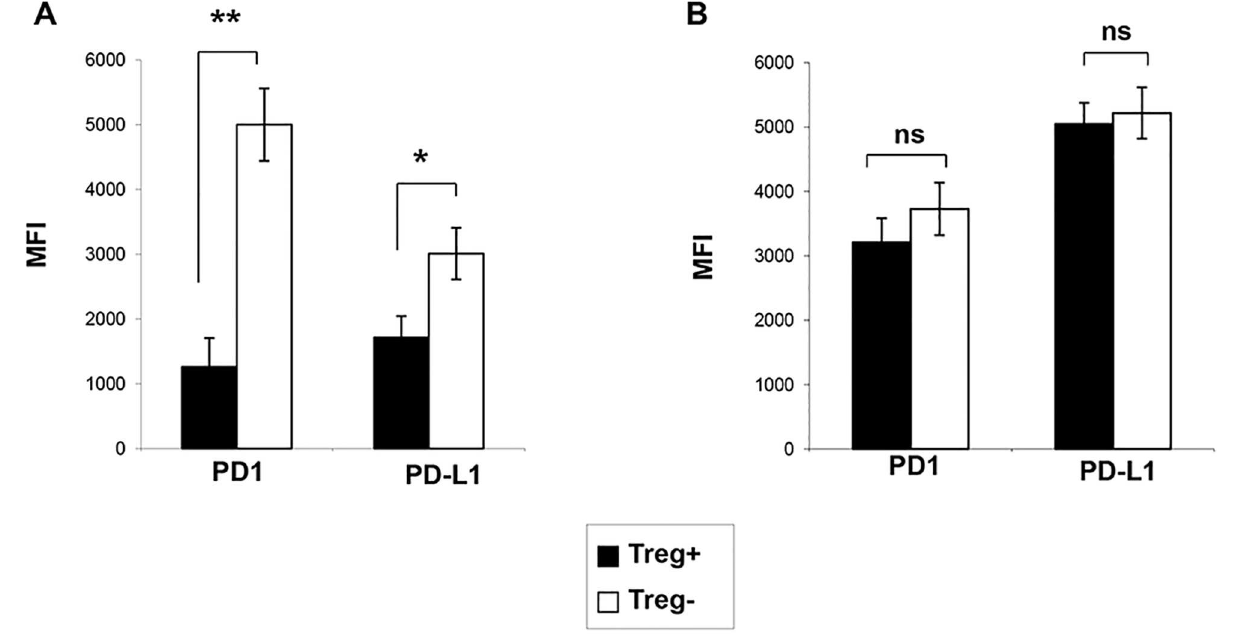
Fig 4. Treg-mediated regulation of PD-1/PD-L1 expression on CD8 T cells from HIV+ patients is clonally-specific. Pooled data on the levels of PD-1 and PD-L1 expression on CEF-specific (A) and Gag-specific (B) CD8 T cell effectors stimulated overnight in the presence (black) or in the absence (white) of Treg. ( * P < 0.05, *** P < 0.001, n = 10, paired Student